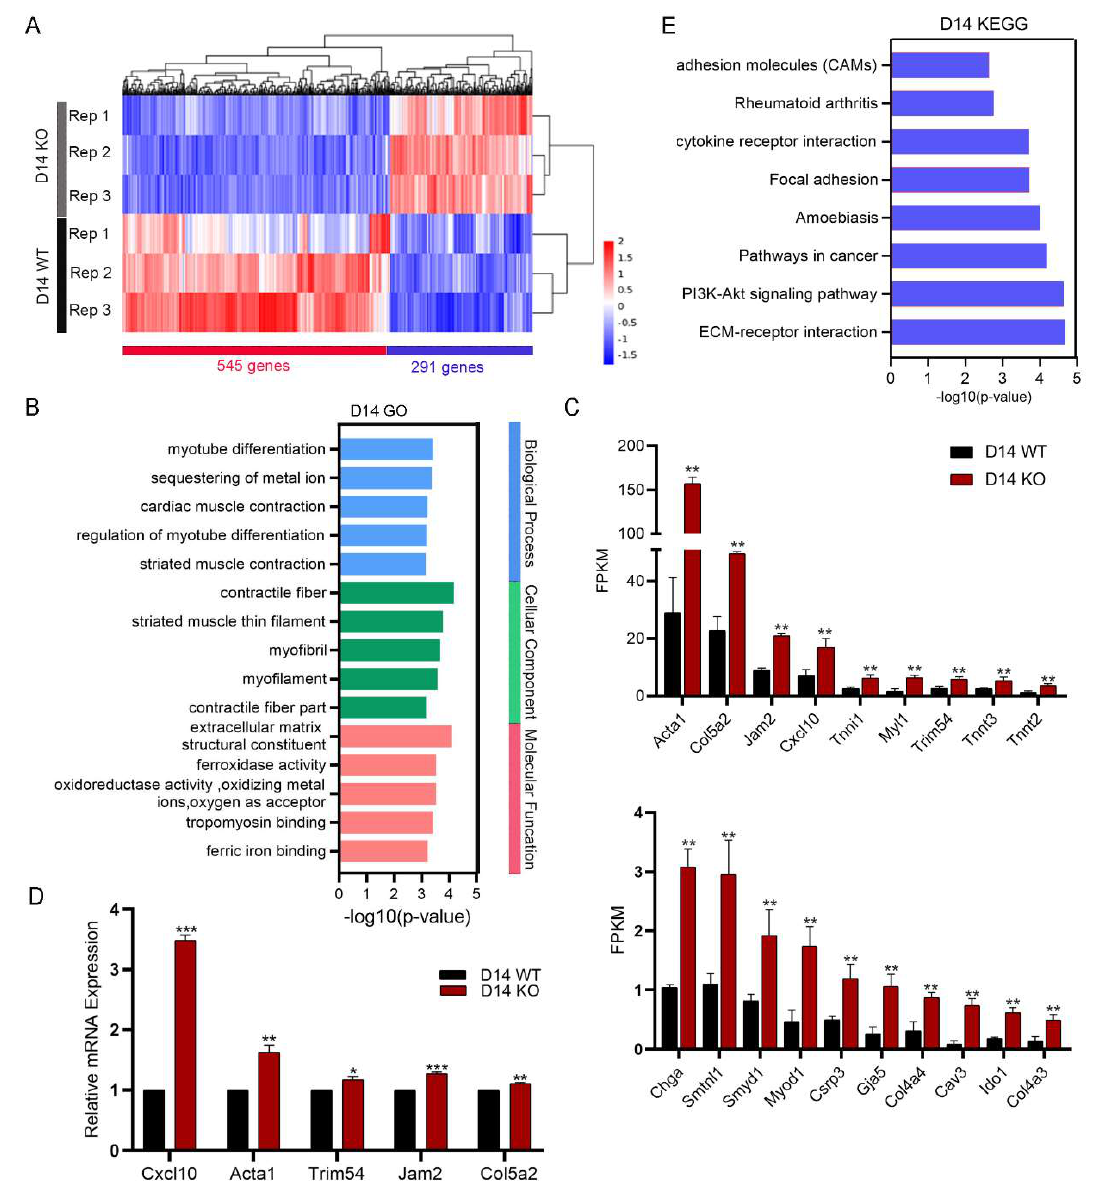
Figure 4. Transcriptome analysis using RNA-seq in Snap29 +/+ and Snap29 − / − differentiated cells. ( A ) Heatmap illustrating DEGs between Snap29 +/+ and Snap29 − / − differentiated cells at day 14. Three biological replicates were analyzed per group. Genes with ≥ 2-fold expression changes, and P adj < 0.05 were chosen for the heatmap. ( B ) The GO analysis of DEGs between Snap29 +/+ and Snap29 − / − differentiated cells. ( C ) FPKMs of genes involved in the development of muscle lineage cells. ( D ) Expression analysis of representative genes in ( C ) by qPCR. ( E ) The enriched KEGG pathways of DEGs between Snap29 +/+ and Snap29 − / − differentiated cells. Mean ± SEM from three biological replicates. * p < 0.05, ** p < 0.01, *** p < 0.001, ns not significant ( p > 0.05), unpaired two-tailed Student’s t